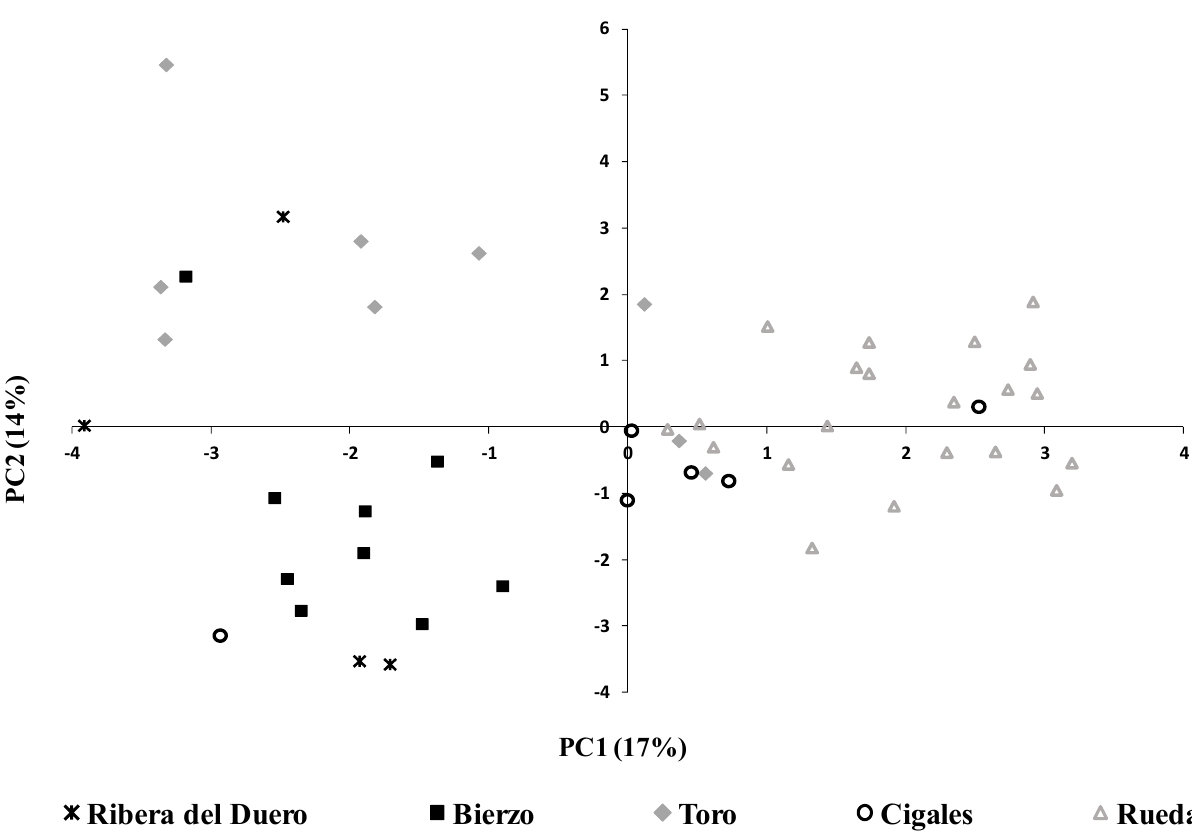
Figure 1. Distribution of white wines from different PDOs in the plot defined by the first two principal components (PC). In the case of ros é wines, the first two PCs represented 45% of the total variance (Figure 2) . PC1 explained 28% of the total variance and allowed differentiating between the wines from CI (on the right side of the plane) and the rest of the wines (on the left side of the plane). Groups of volatile compounds such as terpenes, vanillic derivatives, positive phenols and whiskey lactones had an important role in the differentiation of the wines from CI (Table 5). On the other hand, ethanol content and fatty acids were more associated with the differentiation of the wines from RD, BI and TO (Table 5). PC2 explained 17% of the total variance which mainly allowed clear differentiation between the wines from BI and RD, with LMW and VLMW polysaccharides highly associated with the wines from BI (Table 5).